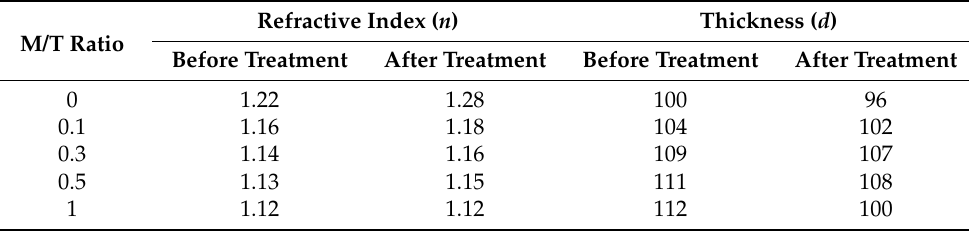
Table 1. Changes in the refractive index and thickness of M/T ratio film after vapor treatment.